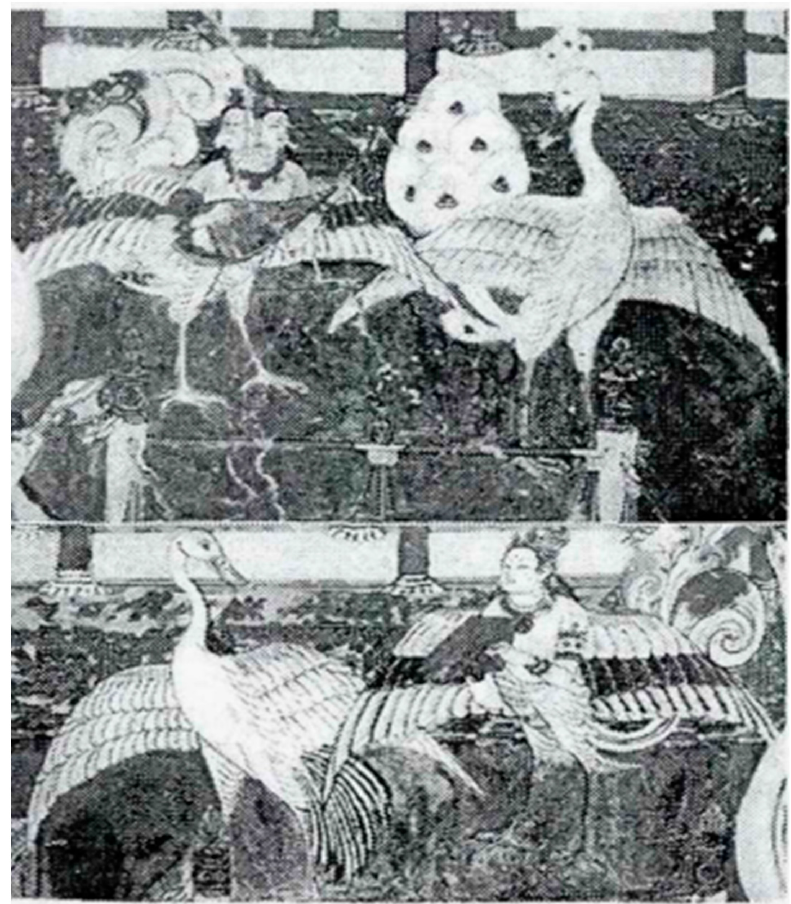
Figure 4. Partial image: The variation of the Sutra of the Visualization of the Amit ā yus S ū tra (Fo shuo guan wuliangshou fo jing 佛说观无量寿經 or Guan jing 觀經 ) from Cave 25 of the Yulin 榆林 Cave in the Mogao Caves at Dunhuang (Zhang 2018, p. 21).